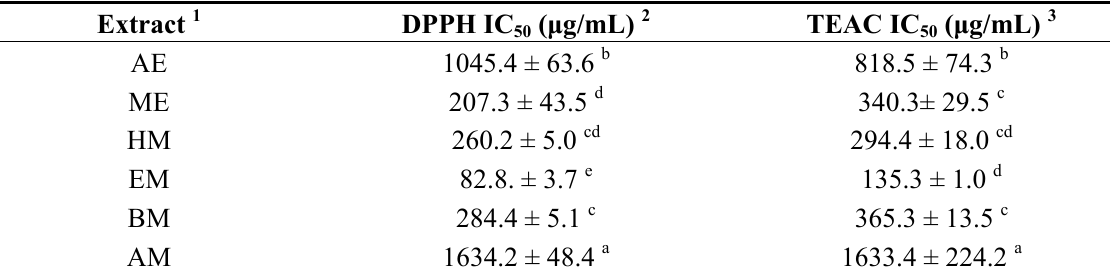
Table 3. Scavenging effects of different solvent extracts from Bidens pilosa on the DPPH radical and